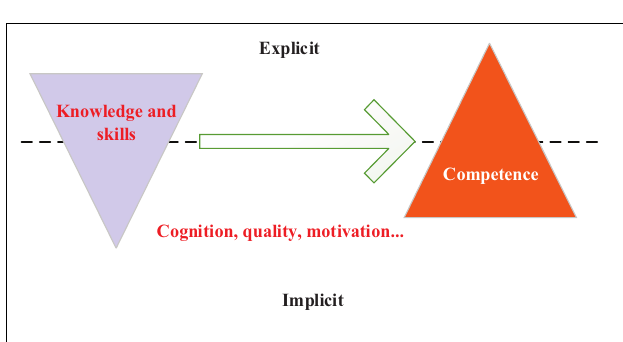
FIGURE 2 | Comparison of talent selection